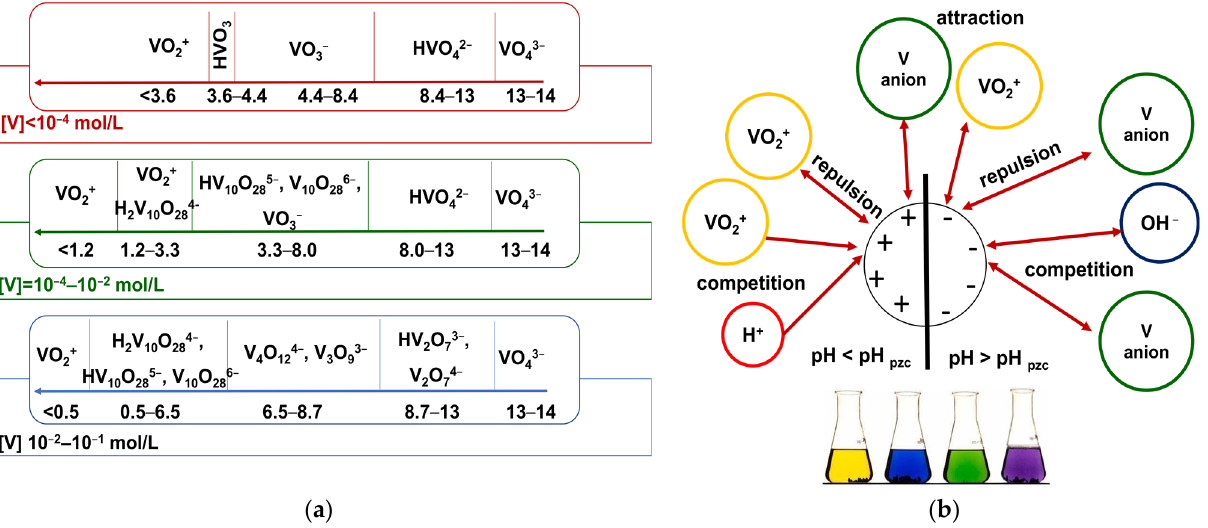
Figure 6. Vanadium species ( a ) and possible interactions with an adsorbent ( b ) depending on its concentration ( a ), pH ( a , b ), and surface charge ( b ).